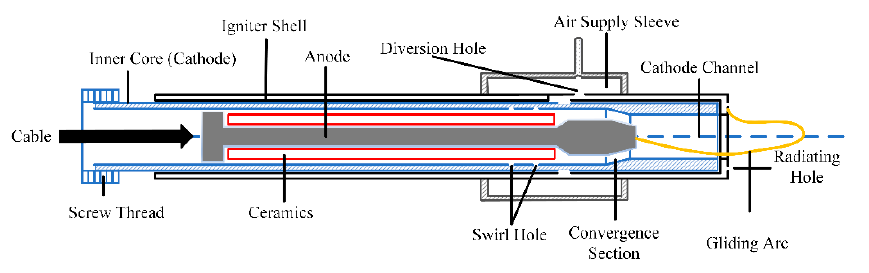
Figure 1. Gliding arc plasma igniter driven by pressure difference.